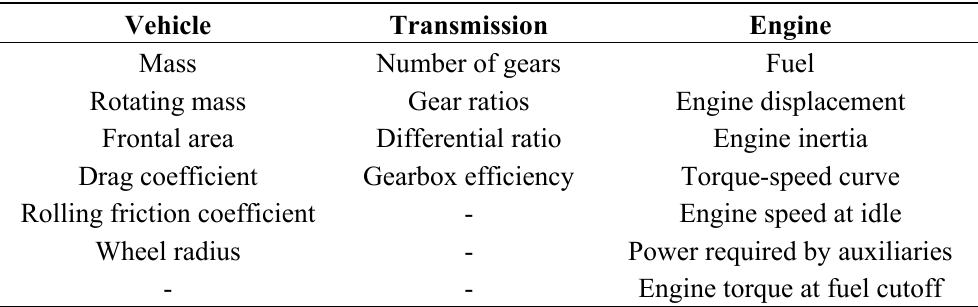
Table 1. Main vehicle model